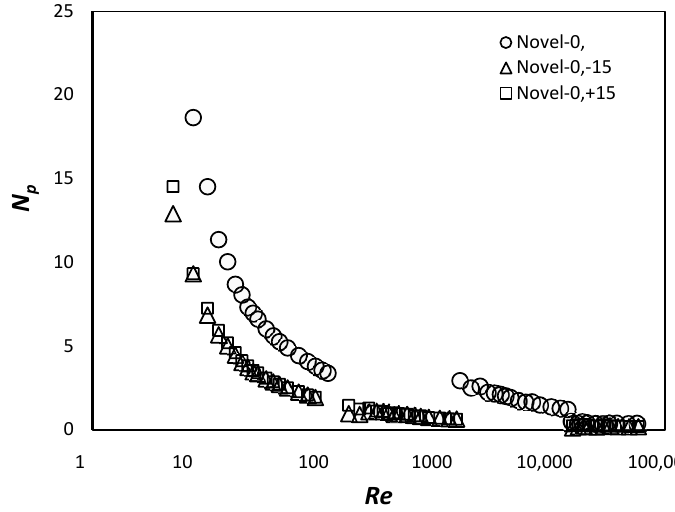
Figure 15. The power number N p from experimental measurements as a function of the Reynolds number for various angles of novel impeller “blades”.